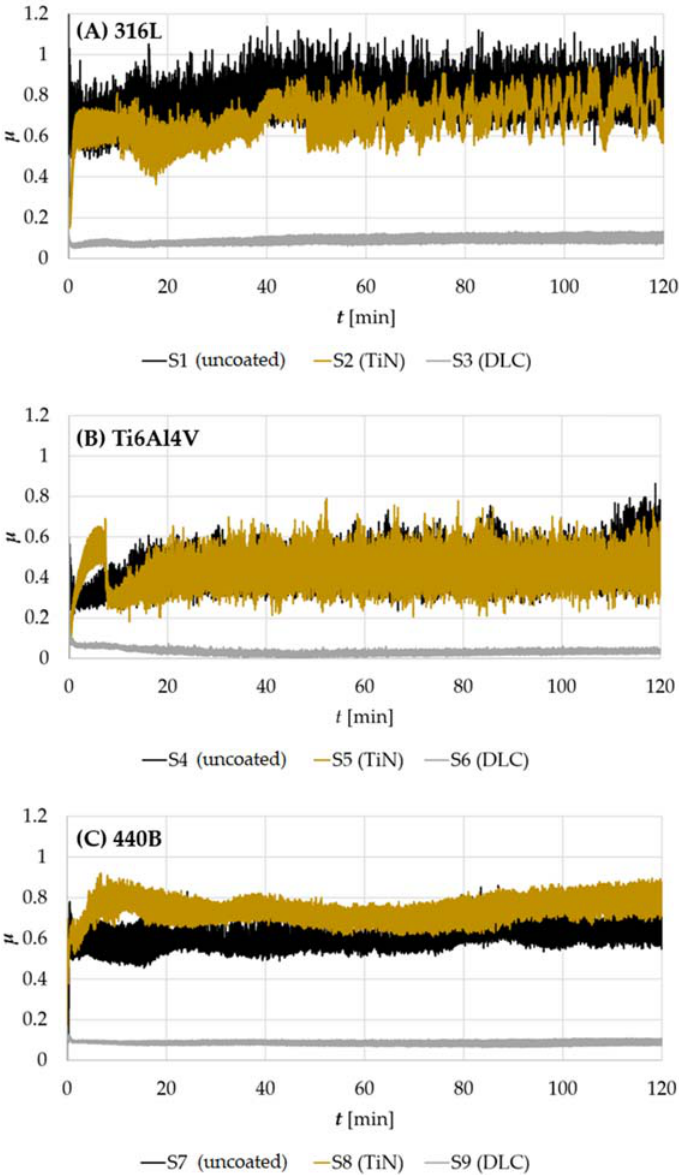
Figure 4. Fluctuations of COF in time, registered for samples fabricated of: ( A ) 316L austenitic stainless steel, ( B ) Ti6Al4V titanium alloy, ( C ) 440B stainless steel.